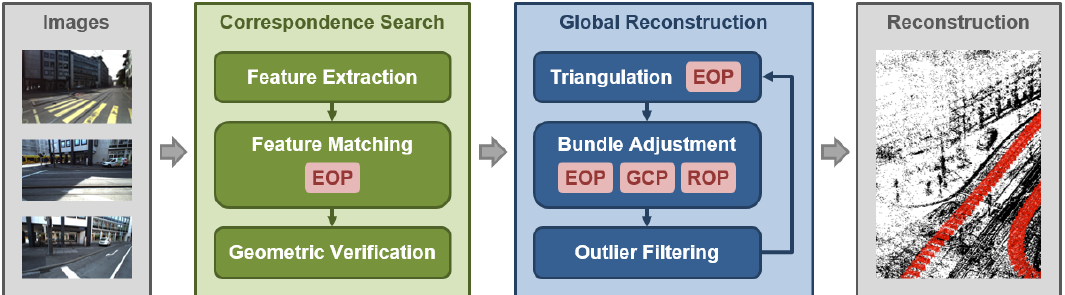
Figure 1. Adapted processing pipeline of COLMAP based on prior exterior orientation parameters